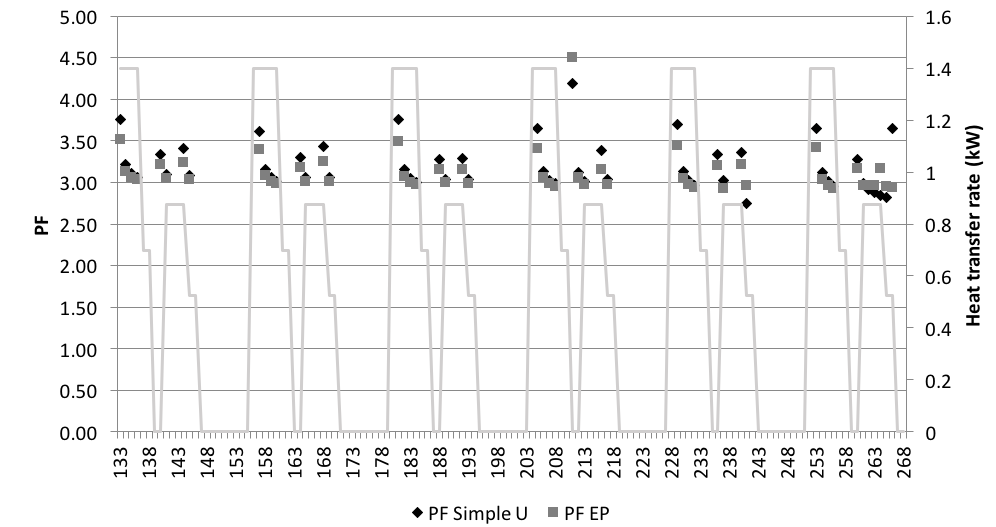
Figure 14. Hourly performance factor (PF) obtained in the single U BHE and EP